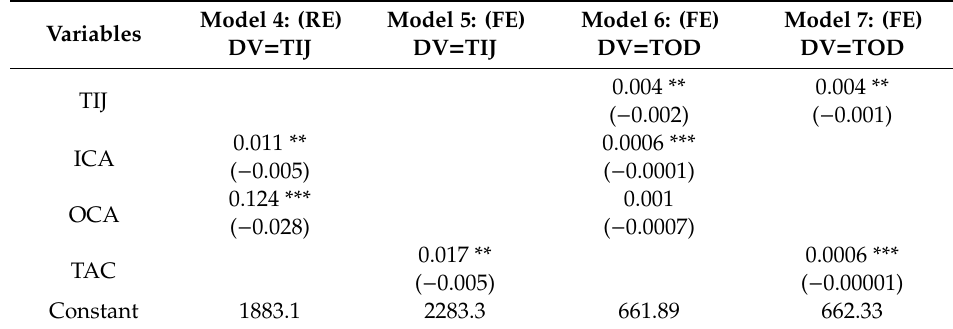
Table 3. Regression analysis for the prediction of total injuries, total number of deaths by total injuries, inside-city accidents, outside-city accidents, and total number of accidents Model 4: (RE) Model 5: (FE) Variables DV = TIJ